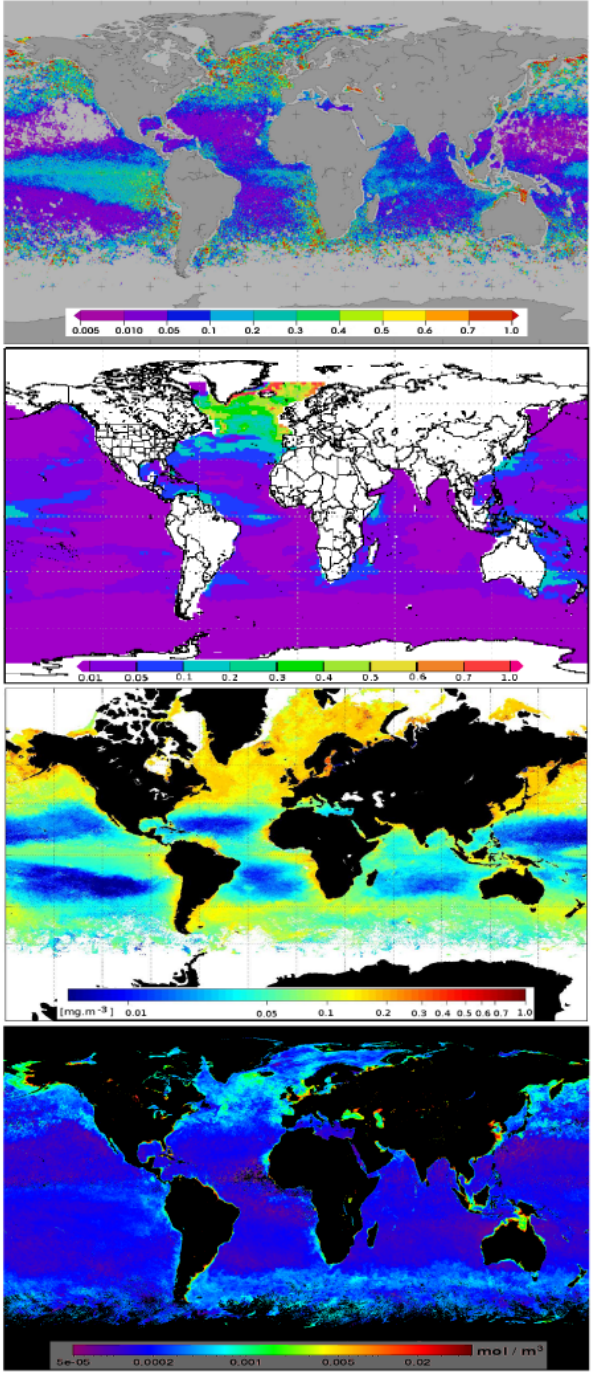
Fig. 7. Comparison of the PhytoDOAS coccolithophore chl a [mgm − 3 ] (upper panel) with the NOBM coccolithophore chl a [mgm − 3 ] (second upper panel), the haptophytes chl a [mgm − 3 ] (third panel) and the MODIS PIC concentration [molCaCO 3 m − 3 ] (lower panel). All results represent the seasonal-mean values over the months of April, May and June 2005.